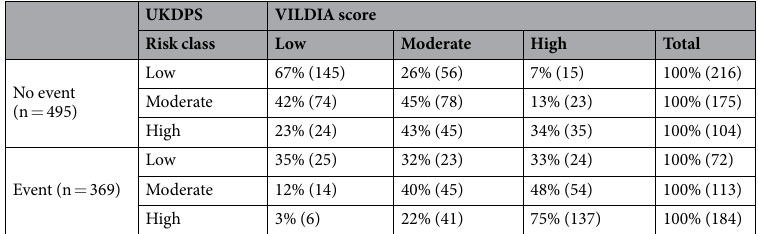
Table 2. Reclassification table. Reclassification table comparing the VILDIA score with the UKPDS score for all-cause mortality.